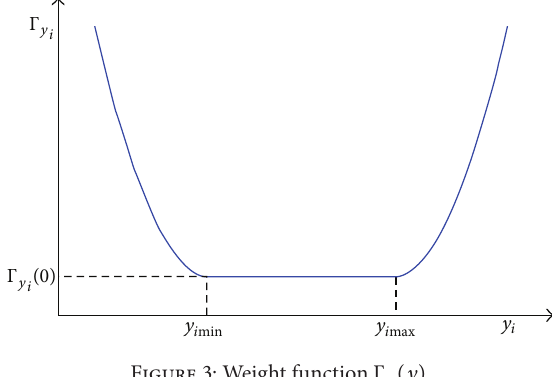
Figure 3: Weight function Γ 𝑦